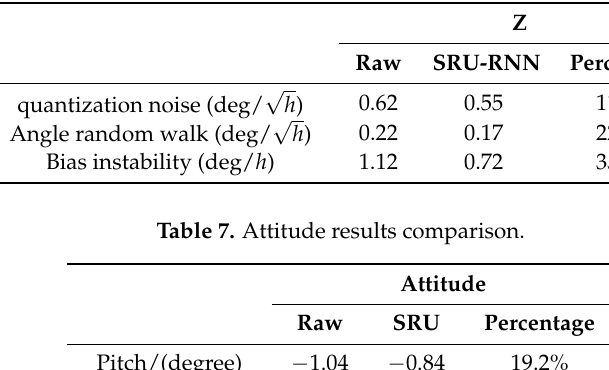
Figure 12. Allan variance comparison between de-noised and raw signals for X-axis gyroscope. Table 6. Parameters of Z-axis gyroscope results.